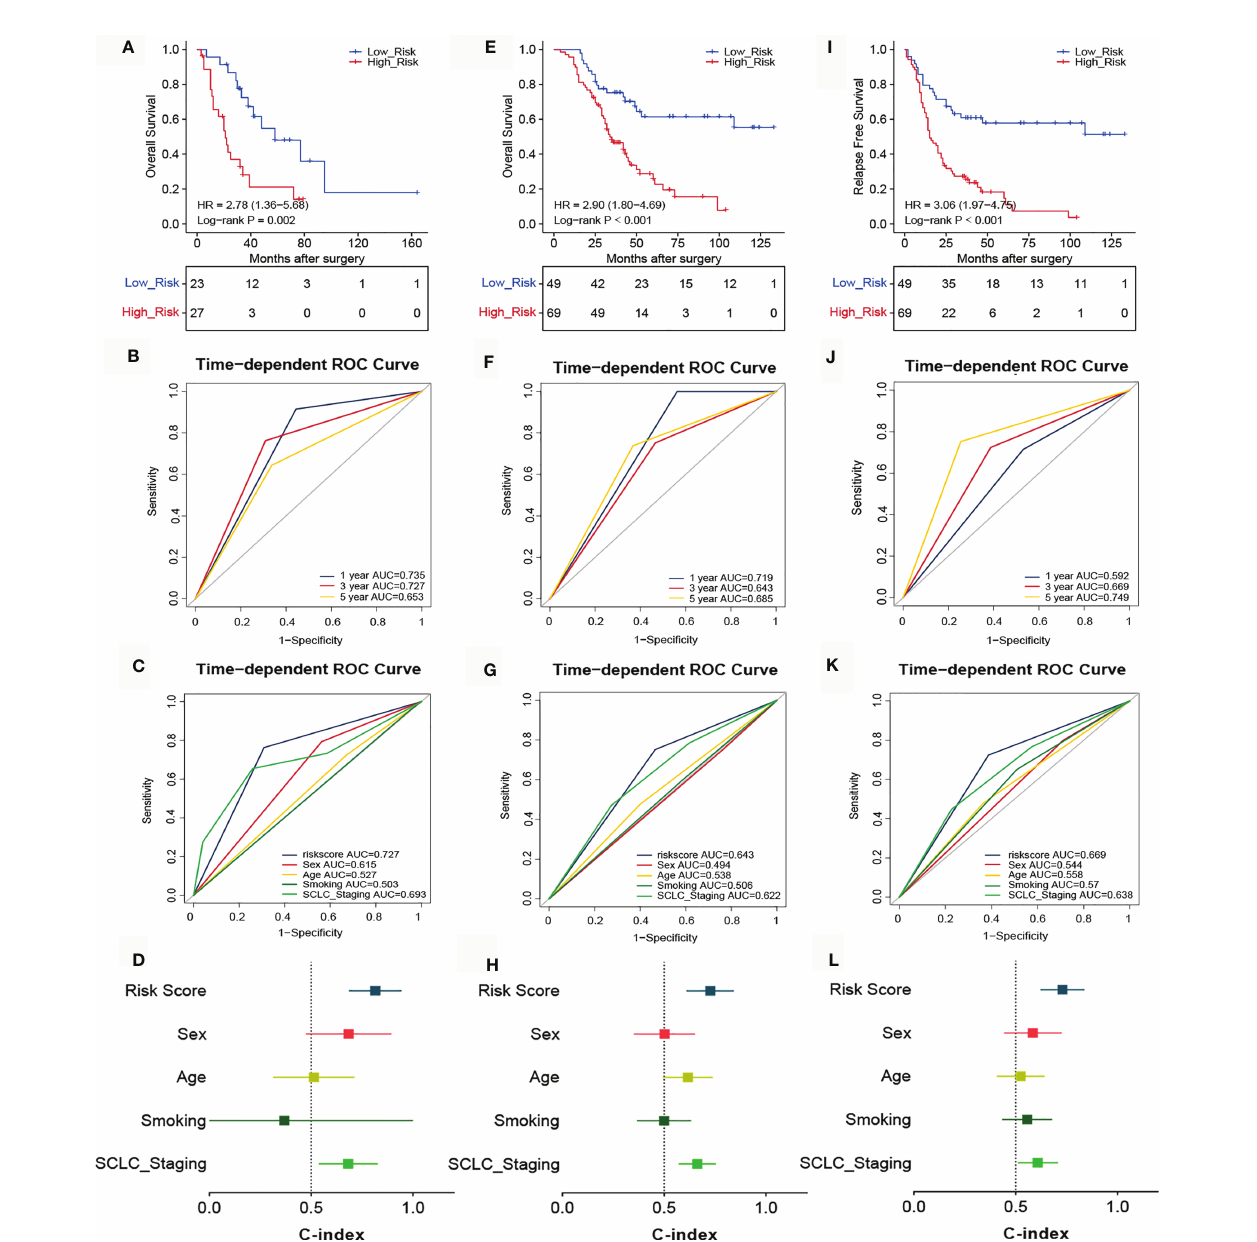
FIGURE 5 | Association between risk score and the survival bene fi t of adjuvant chemotherapy in patients with SCLC. Kaplan-Meier (A) and ROC analyses of OS according to different risk groups in the training cohort (B, C) . (D) C-indexes for evaluating the performance of the signature for predicting the OS of the training cohort. Kaplan-Meier (E) and ROC analyses of OS according to different risk groups in the validation cohort (F, G) . (H) C-indexes for evaluating the performance of the signature for predicting the OS of the validation cohort. Kaplan-Meier (I) and ROC analyses of RFS according to different risk groups in the validation cohort (J, K) . (L) C-indexes for evaluating the performance of the signature for predicting the RFS of the validation